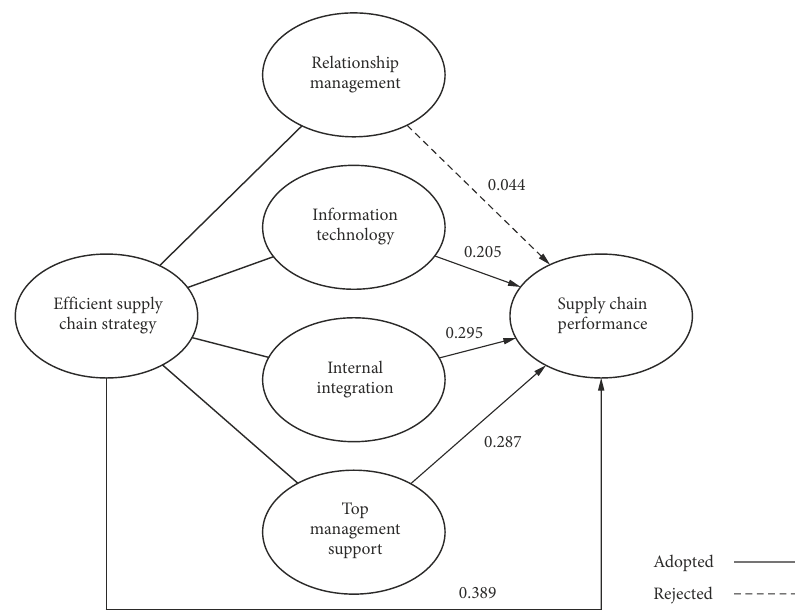
Figure 2. Structural model analysis